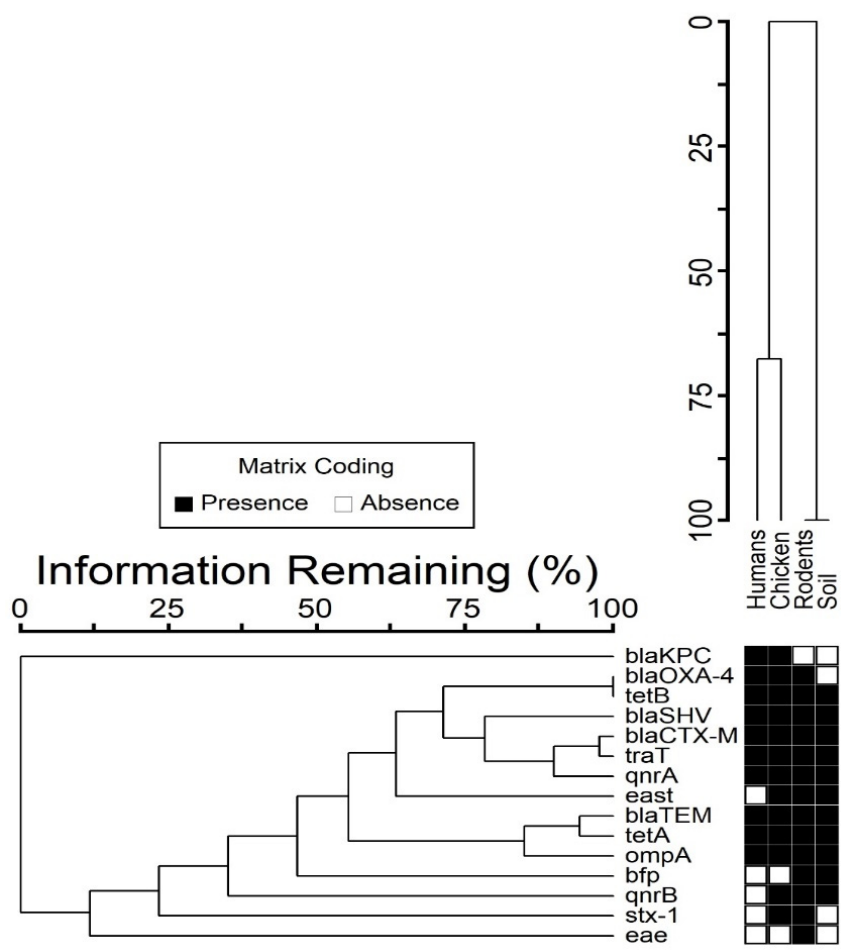
Figure 3. Co-occurrence of resistance and virulence genes in isolates from different sample sources.